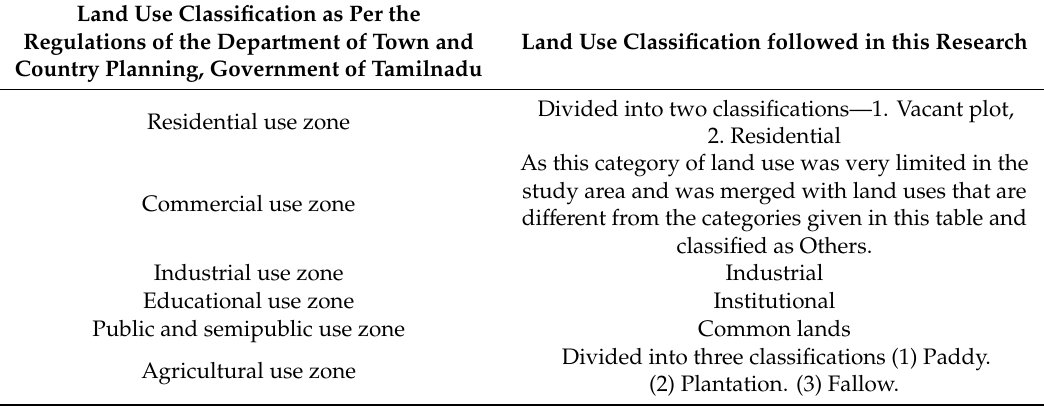
Table 2. Land use classification